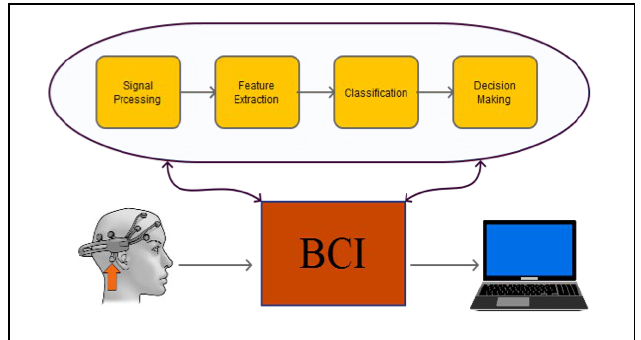
Figure 1. Typical Brain Computer Interaction structure, including data acquisition and signal processing; finally, the interpreted action is shown as a